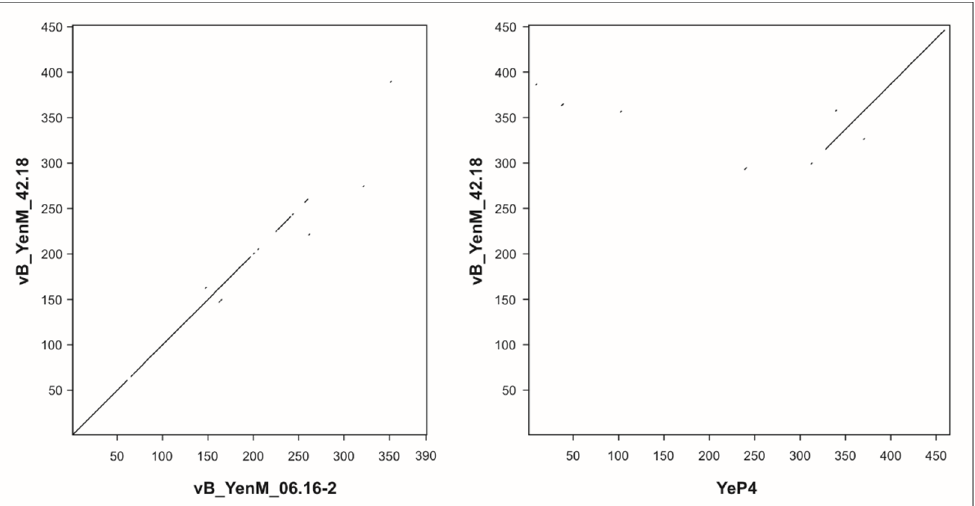
Figure 7. Relationship of the tail fiber protein of group 3 phage vB_YenM_42.18 to that of group 2 phage vB_YenM_06.16-2 and YeP4. Dot plot alignments were generated using DS Gene (v 2; Accelrys Inc., USA) using default parameters (window size 30, hash value 6, min. score 65) and composited to a multi-dot plot using Corel Draw X8 (V 18.1.0.690; Corel Corporation).